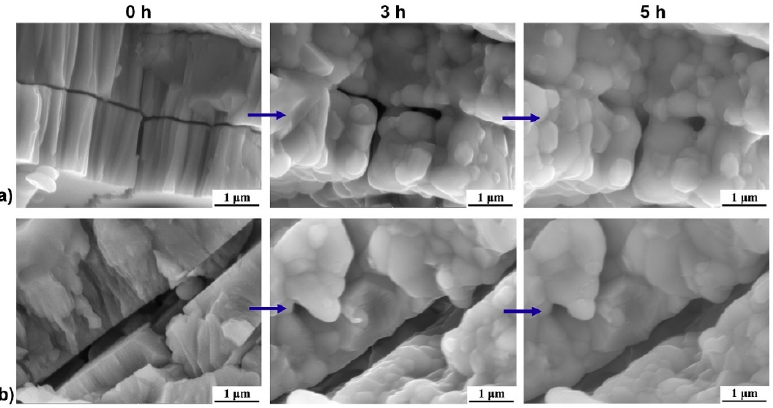
Figure 17. In situ healing of 2D pores of APS-TBC during thermal exposure: ( a ) a pore of less than 50 nm width ( b ) a pore of approximately 200 nm width [61] .